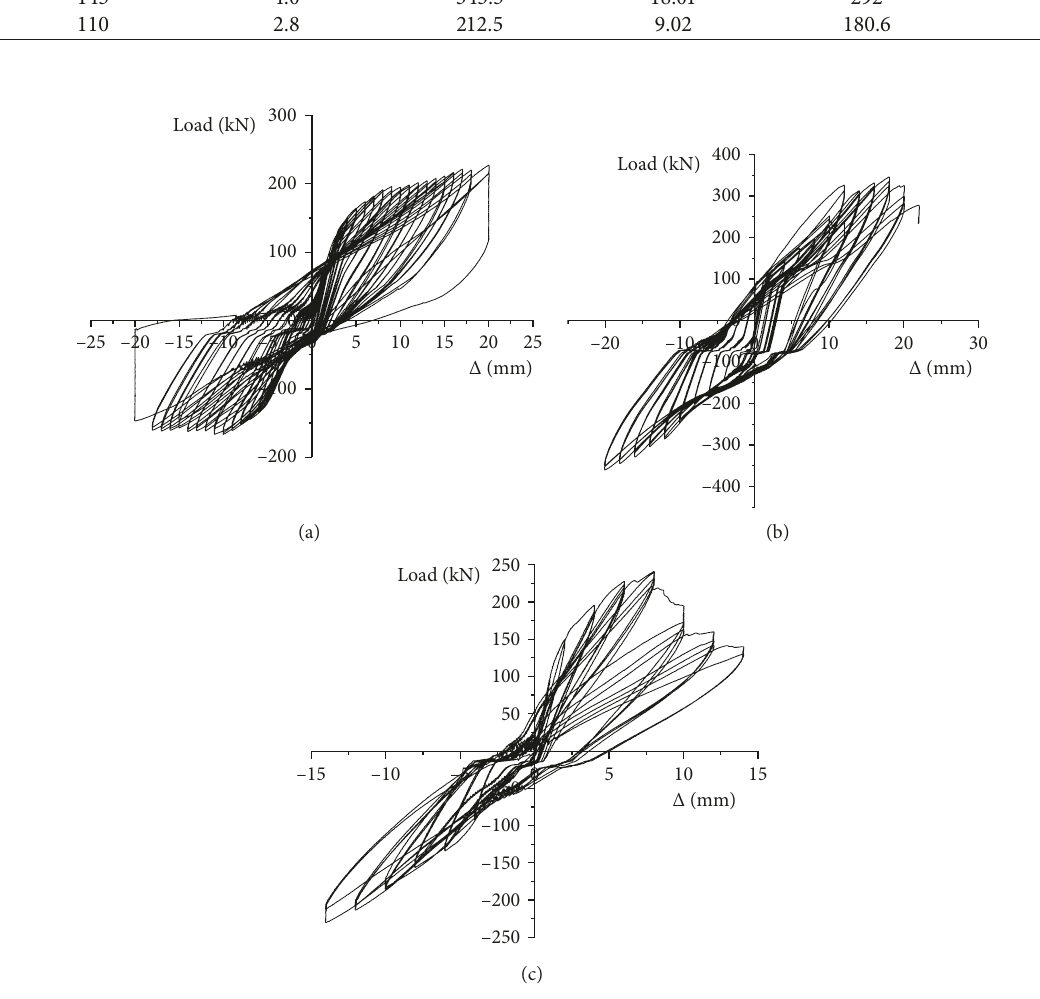
Figure 11: Load-displacement hysteresis diagrams for test walls: (a) A1, (b) A2, and (c) A3.